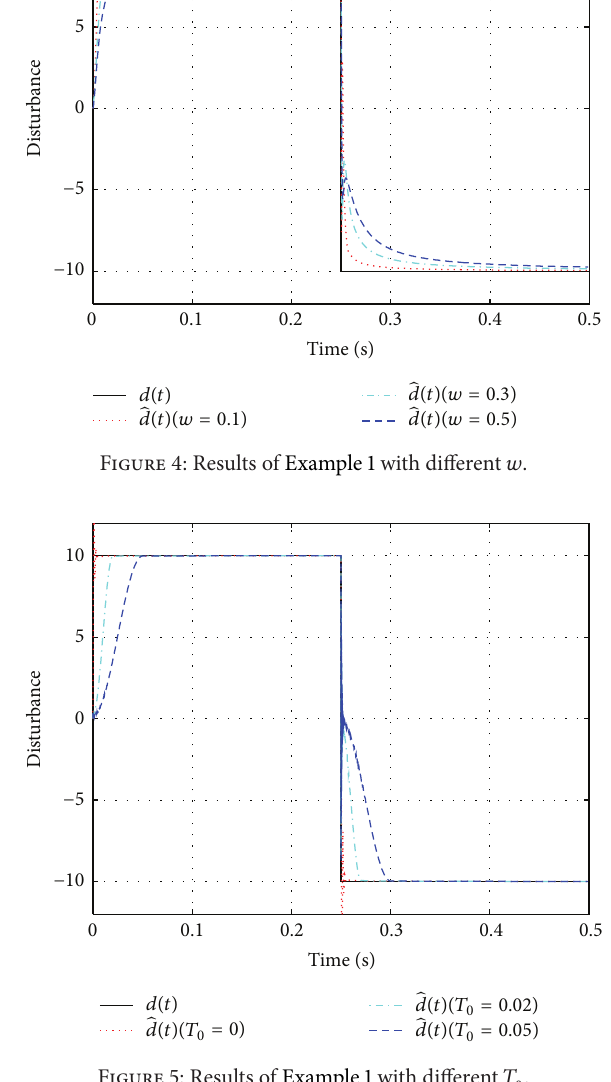
Figure 7: Results of Example 3 with FDOB0, FDOB1, and